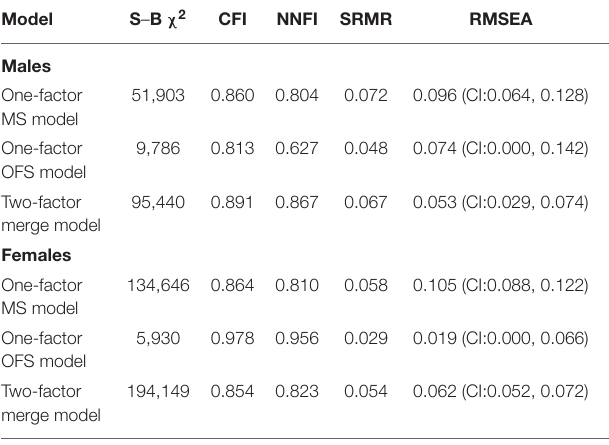
TABLE 4 | Summary of fit indices for the CFAs of MS and OFS for males ( n = 176) and females ( n = 524). Model